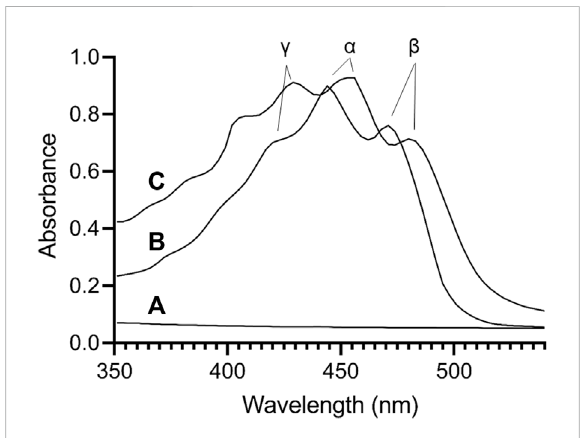
FIGURE 1 UV/Vis absorbance spectroscopy of lutein. Spectra were collected for (A) control EYPC rHDL (no lutein) in PBS; (B) lutein (10 μ g) in ethanol; (C) lutein ND (10 μ g as lutein) in PBS. Samples were scanned from 350 to 570 nm on a Spectramax M5